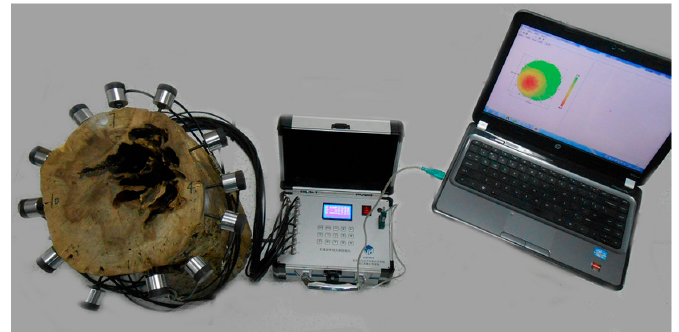
Figure 4. Simulation data (graph of defect distribution and graph of rays) and experimental data (real image of sample and graph of rays): ( a ) Single circle distribution; ( b ) single edge distribution; ( c ) two-edge distribution; ( d ) two-rectangle distribution; ( e ) three-circle distribution; ( f ) firmiana timber with hole defects; ( g ) chinaberry timber with knot defects; ( h ) pecan timber with crack defects.